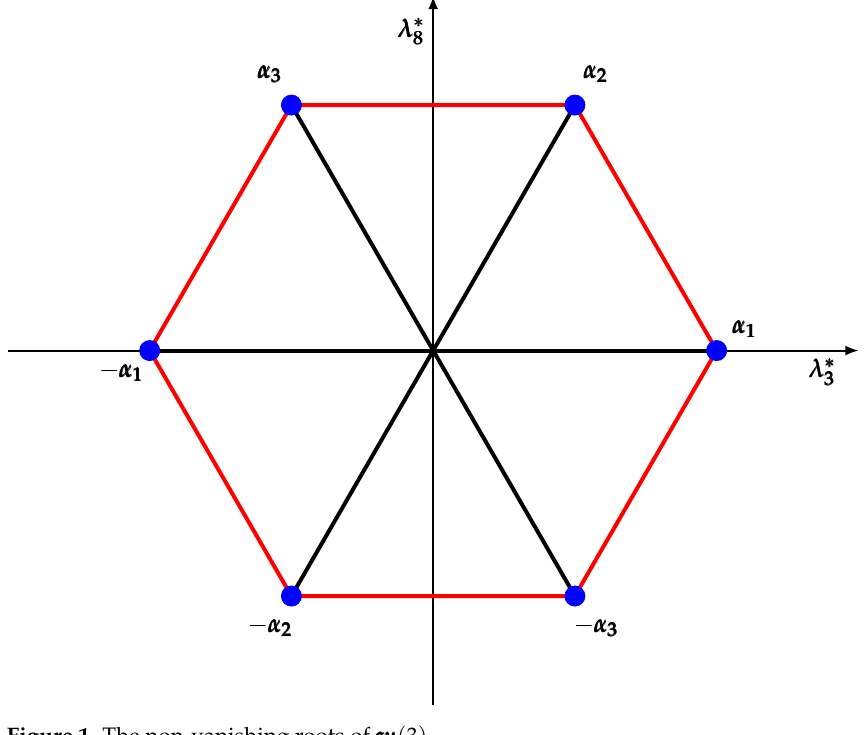
Figure 1. The non-vanishing roots of sususu ( 3 )